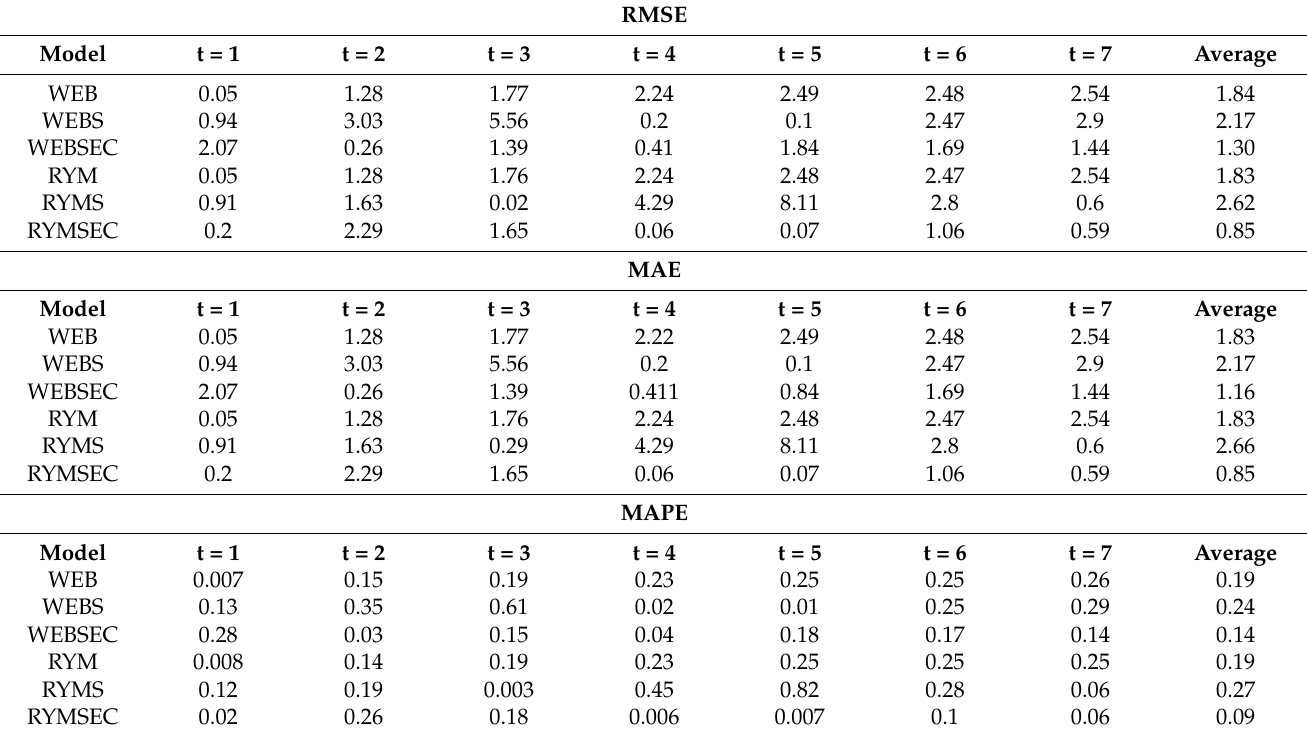
Table 4. Performance results of different WSP models for West Virginia Hills.